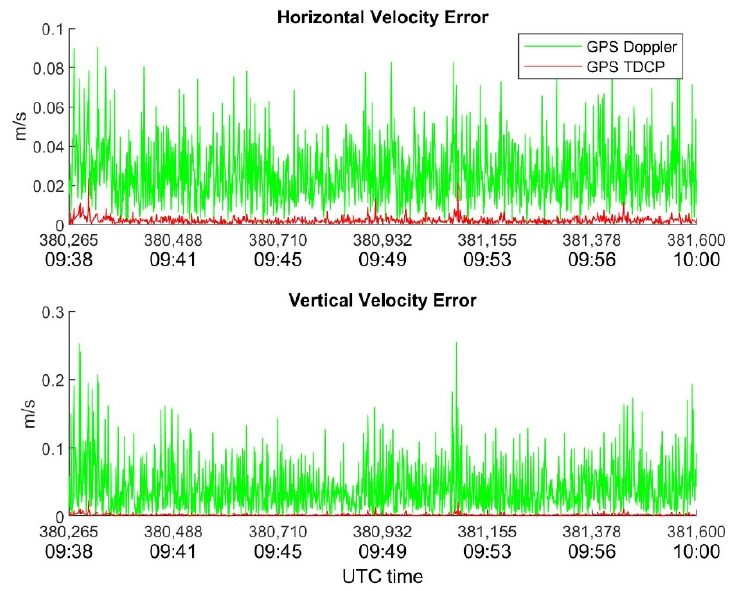
Figure 8. u-blox horizontal and vertical velocity errors as function of time. RAIM is applied.